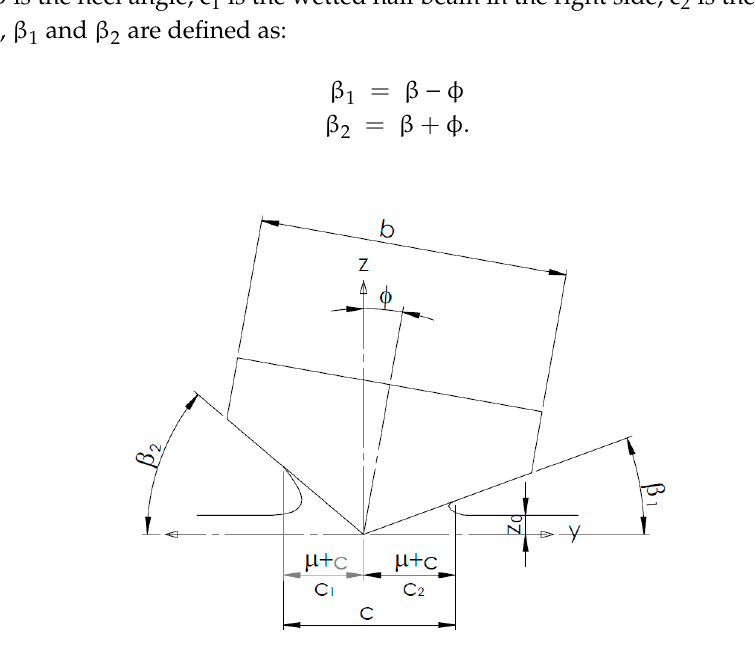
Figure 1. Impact with symmetry entry.